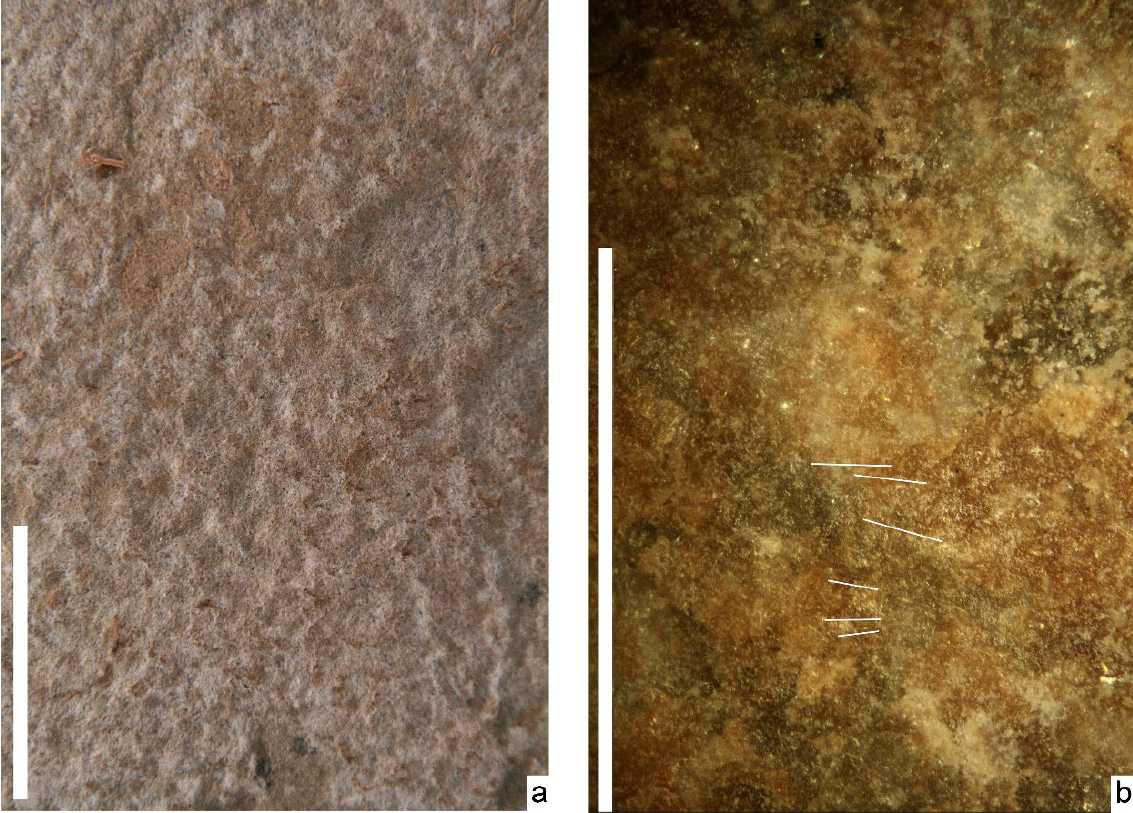
Figure 10. Micro-photo of the working surfaces of the experimental lower grinding stone (a - 50×, scale bar = 1 mm) and mano (b - 100×, scale bar = 1 mm). White lines in the micro-photo emphasize thin thread-like linear traces.